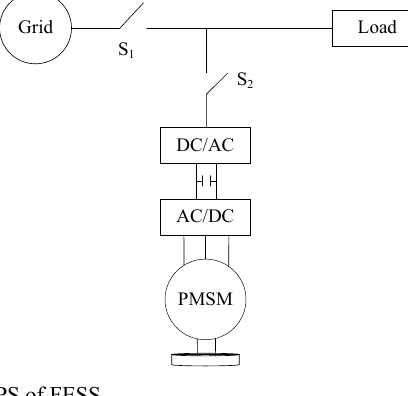
Fig. 8. The Backup Type UPS of